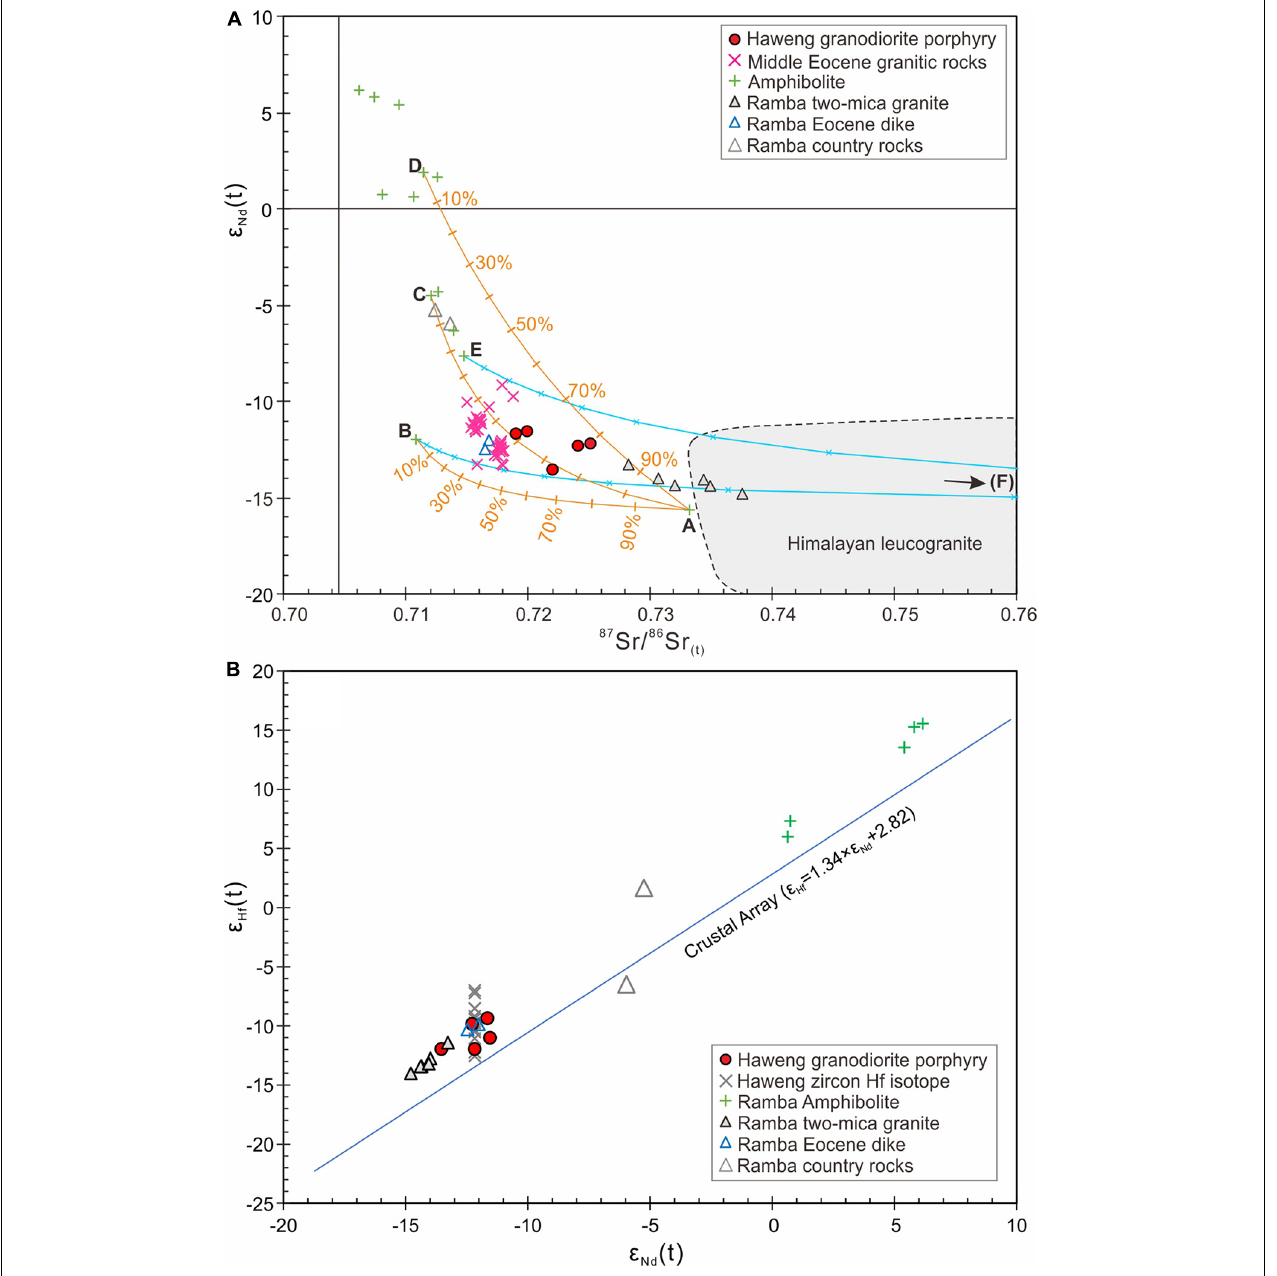
FIGURE 7 | (A) Sr–Nd and (B) Nd–Hf isotope systematics of Haweng granodiorite porphyries and related rocks. The end-member components for amphiolites (A: T0389-17; B: T0394-6; C: T0321-08; D: T0394-21; E: T0394-8) and metapelite (F: T0321-12) are from Zeng et al. (2009) and Zeng et al. (2011). Data sources: amphibolite: Zeng et al. (2011) and Liu et al. (2014); middle Eocene granitic rocks: Zeng et al. (2011); Aikman et al. (2012), and Hou et al. (2012); Ramba Eocene dikes, country rocks and two-mica granite: Liu et al. (2014); Himalayan leucogranite: Zhang et al. (2004); King et al. (2011), and Guo and Wilson (2012) and references